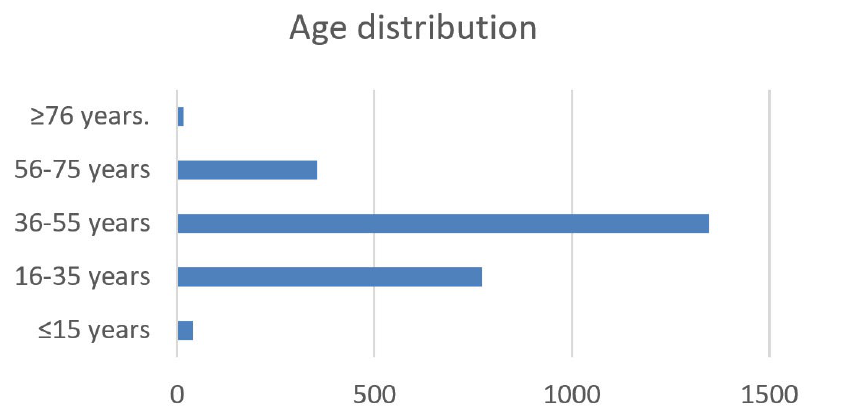
Fig. 5. Age-wise distribution of MTB DNA